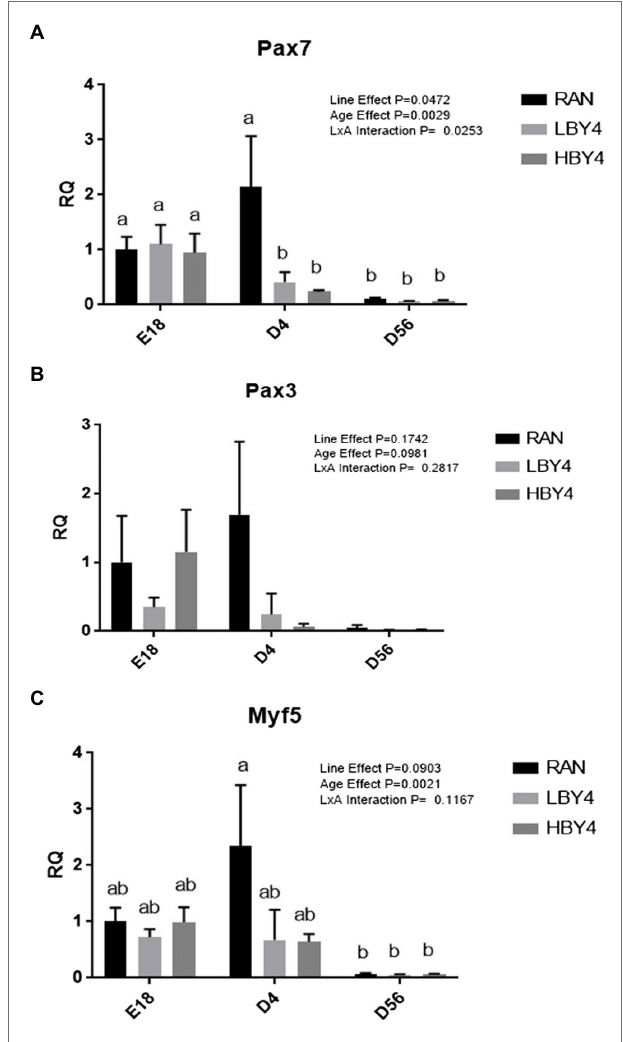
FIGURE 3 | Relative gene expression (Mean ± SE) of Pax7 (A) , Pax3 (B) , and Myf5 (C) at embryonic day 18, d4 and d56 post-hatch for the HBY4, RAN, and LBY4 lines. Different letters indicate significant differences at p < 0.05. Pax7-paired box protein 7, Pax3-Paired box protein 3, Myf5- myogenic regulatory factor 5, RAN-random bred control, HBY4-high percent breast yield at 4 days post-hatch, and LBY4-low percent breast yield at 4 days